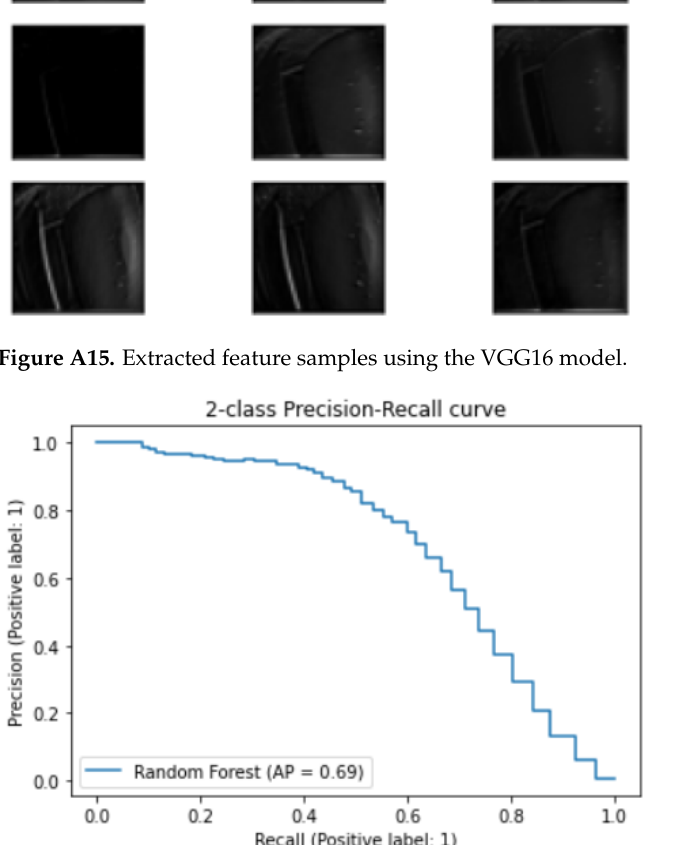
Figure A16. Precision–recall curve for the Random Forest model based on transfer